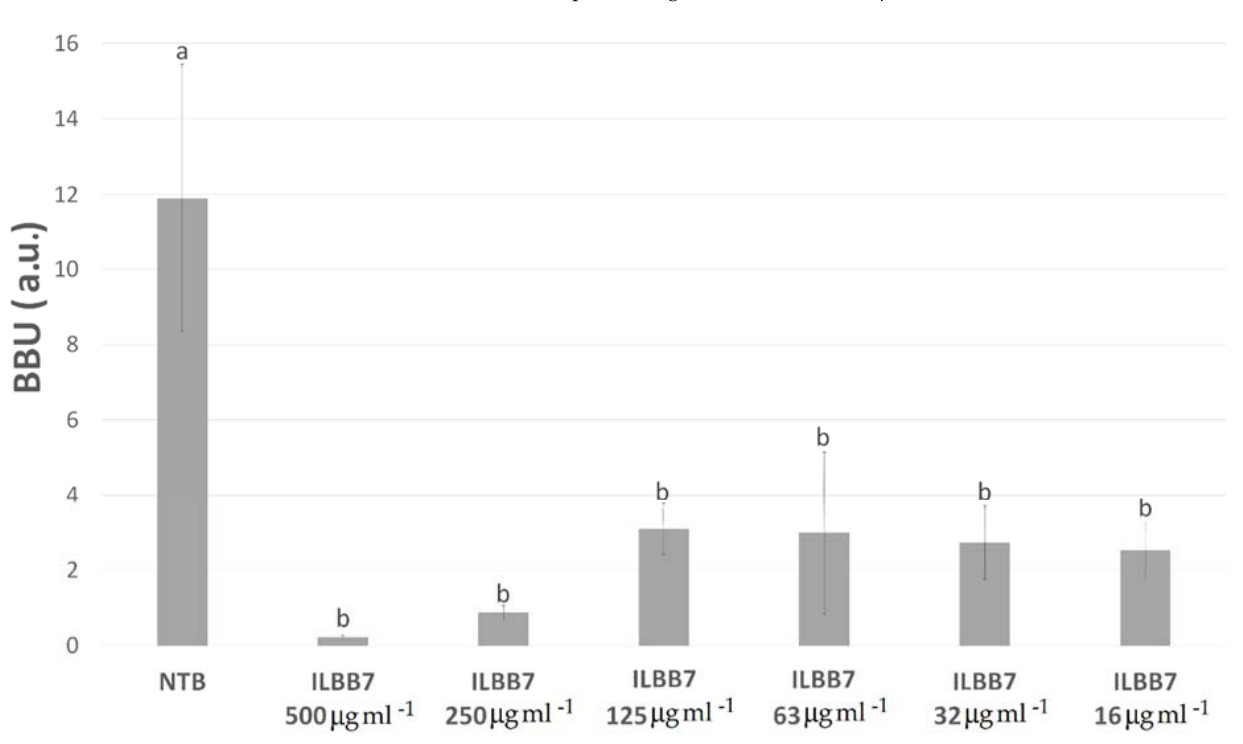
Figure 3. Inhibition of Staphylococcus aureus biofilm by different concentrations of ILBB19 extract. Different letters (a, b, c, d) represent significant differences ( p < 0.05).